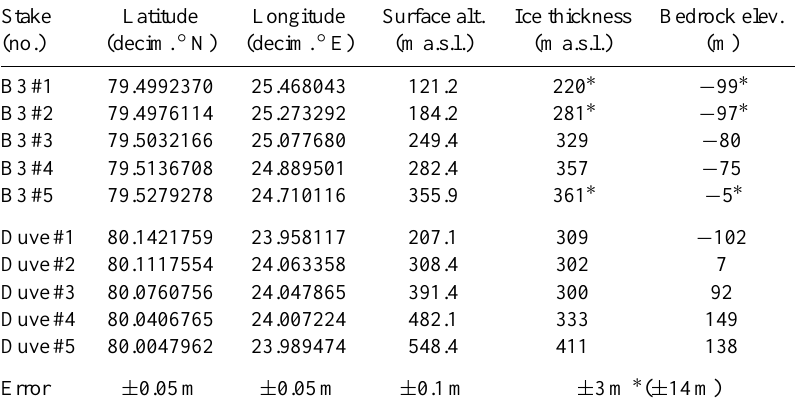
Table 1. Survey locations of stakes along the central flowlines of Basin-3 (B3#1–5) and Duvebreen (Duve#1–5) and their glacier-geometric characteristics. Positions are measured directly and the associated absolute error given in the last row is constant. Ice thickness and hence, bedrock elevation are indirectly measured, the associated error is ice-thickness depended. Values marked by ∗ are interpolated values (see Sect. A).